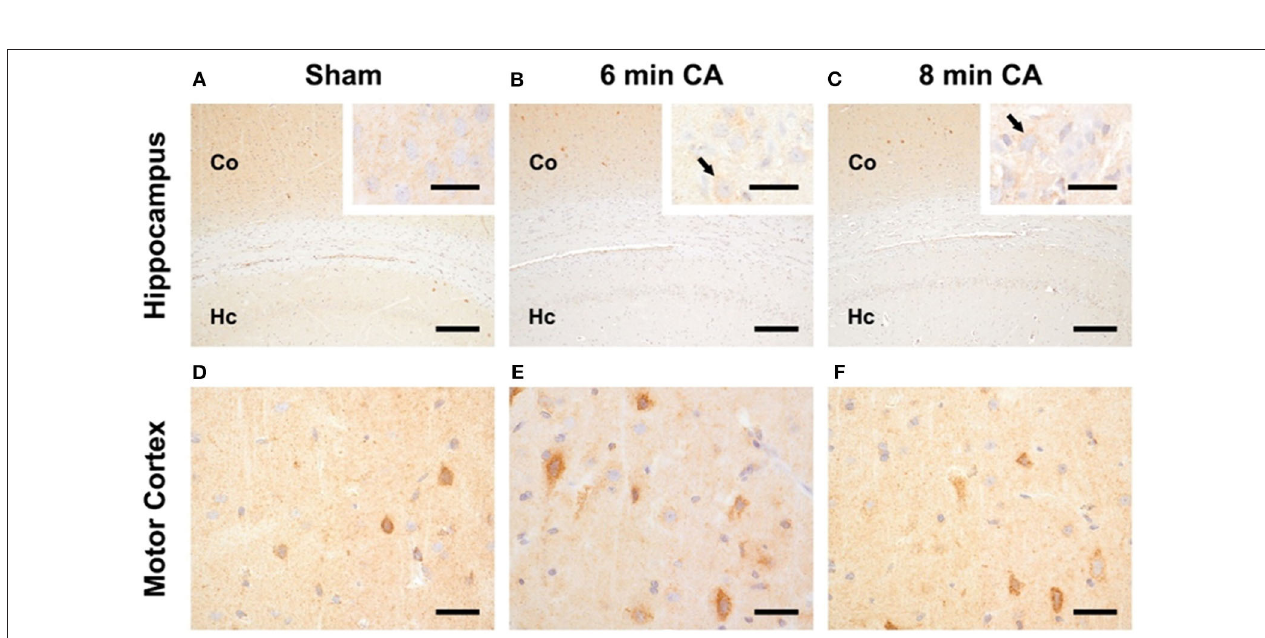
FIGURE 5 | Representative pictures of HO-2 expression in hippocampus and motor cortex. (A–C) Expression of HO-2 in the Hc, bar = 30 µ m, bar in inserts = 150 µ m. (A) The signal intensity in the hippocampus (Hc) of sham animals is nearly similar to the expression in the respective overlying cerebral cortex (Co). (B,C) Reduced expression of HO-2 in the Hc of 6 and 8min CA animals compared to the respective cerebral cortex and compared to sham animals. Inserts: HO-2 expression is detectable in all pyramidal neurons of sham animals (A) , but only in viable pyramidal neurons [arrows in (B,C) ] in CA animals. (D–F) Expression of HO-2 in the mC, bar = 30 µ m; consistent expression of HO-2 in sham (D) as well as 6 (E) and 8min (F) CA animals with increased staining intensity in some neurons.